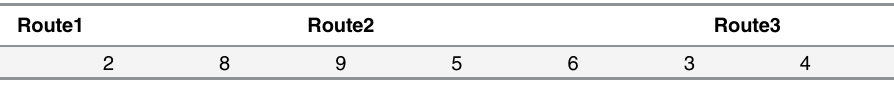
Table 4. Representation scheme